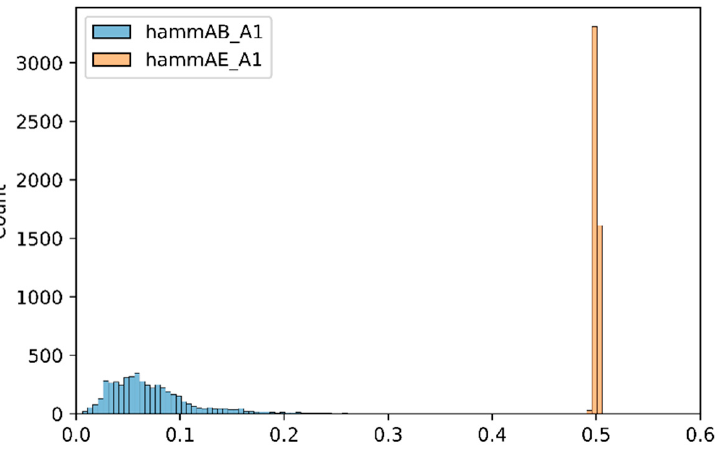
Figure 9. Histogram of normalized Hamming distances between Alice and Bob (0.0736 ± 0.0442), and Alice and Eve (0.5000 ± 0.0017), after the first iteration of the BPAD algorithm.